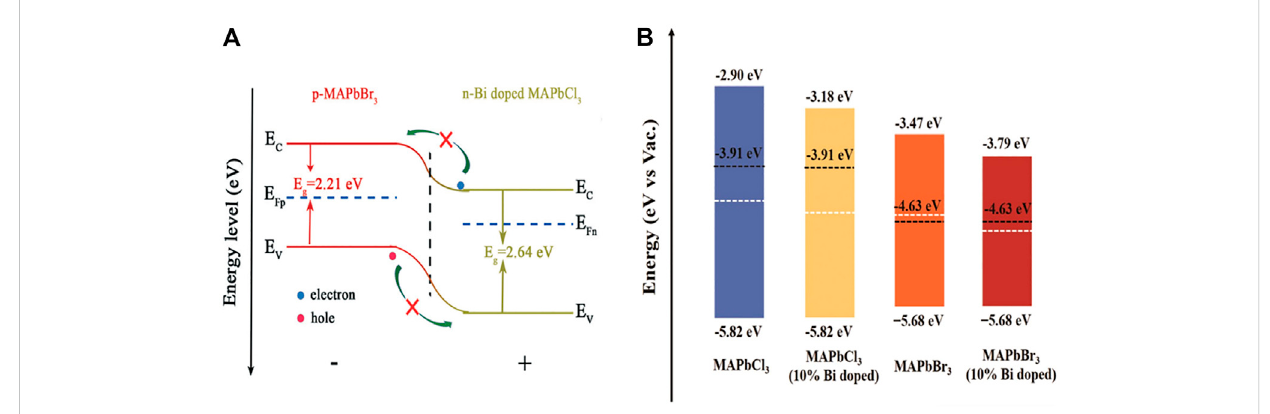
FIGURE 1 (A) Band structure of p-MAPbBr 3 /n-Bi doped MAPbCl 3 heterosystem. (B) Energy level diagram of MAPbCl 3 , 10% Bi doped MAPbBr 3 , MAPbBr 3 and 10% Bi doped p-MAPbBr 3 . Reproduced with permission from Ref. [23] (A, B)